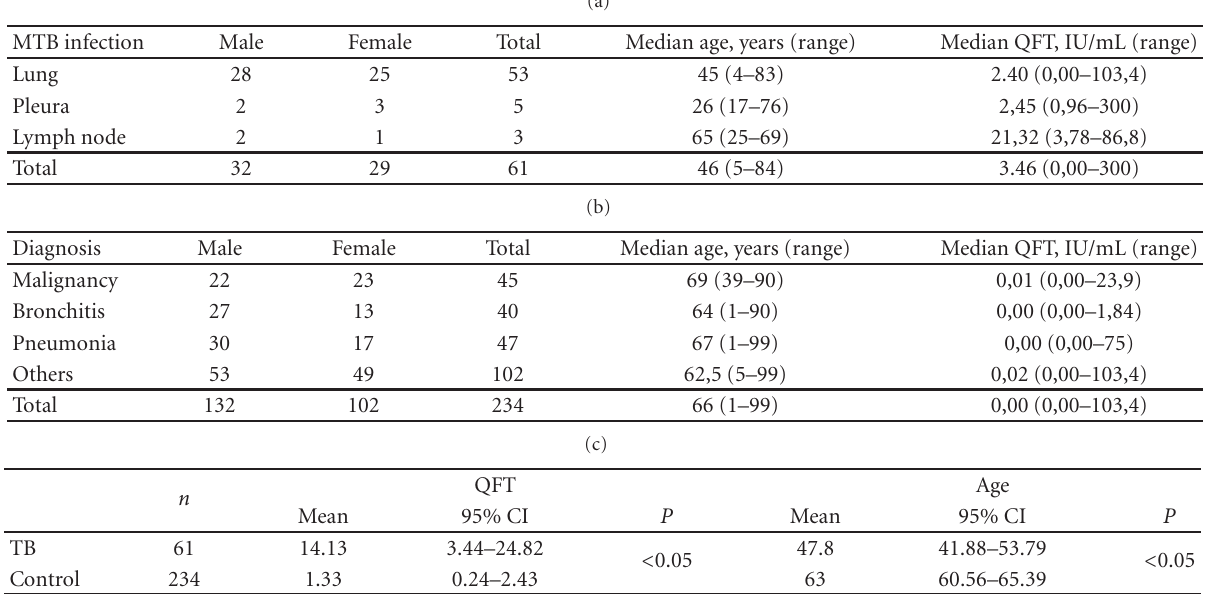
Table 1: (a) Median and range for patient age and IGRA test result for all culture positive cases of active tuberculosis, by organ manifestation. (b) Median and range for age and IGRA test result for all controls, by diagnosis. “Others” includes other lung diseases such as asbestosis, aspergillosis, asthma, bronchiectasis, pleural e ff usion, haemoptysis, fibrosis, and sarcoidosis. (c) Study results for TB cases and controls. ( n : sample size, CI: confidence